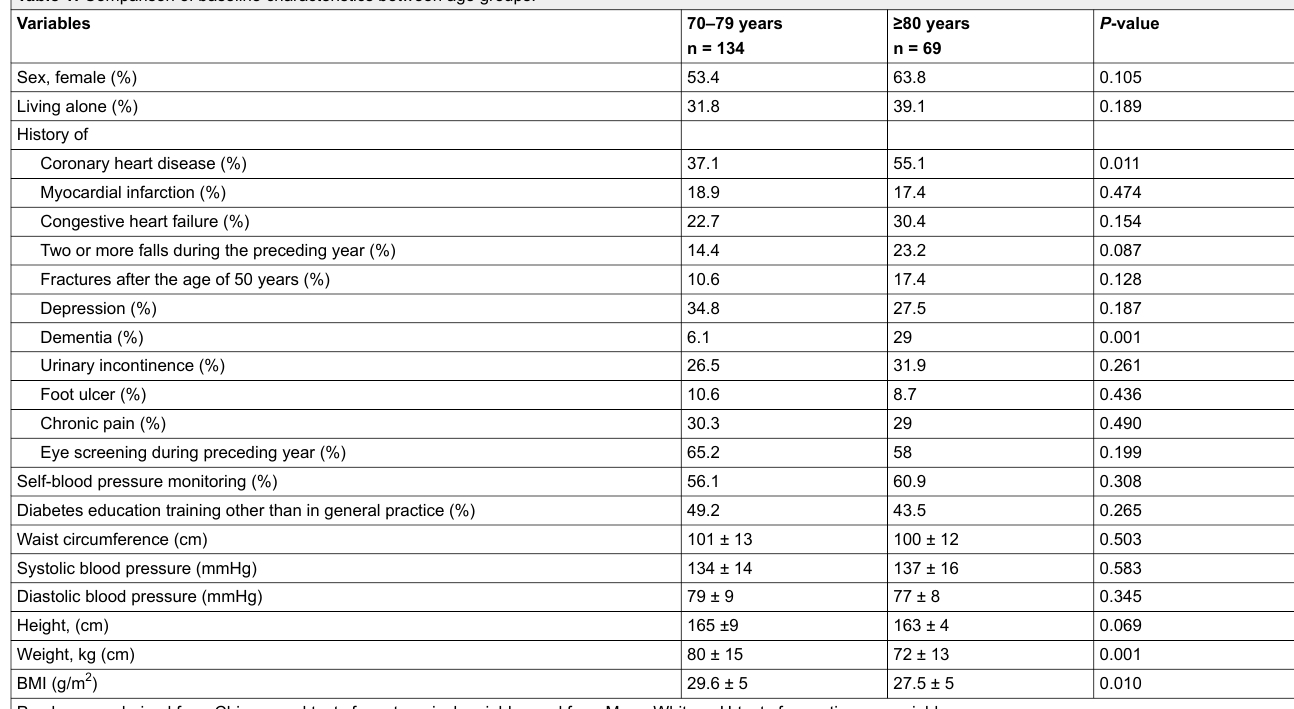
Table 1: Comparison of baseline characteristics between age